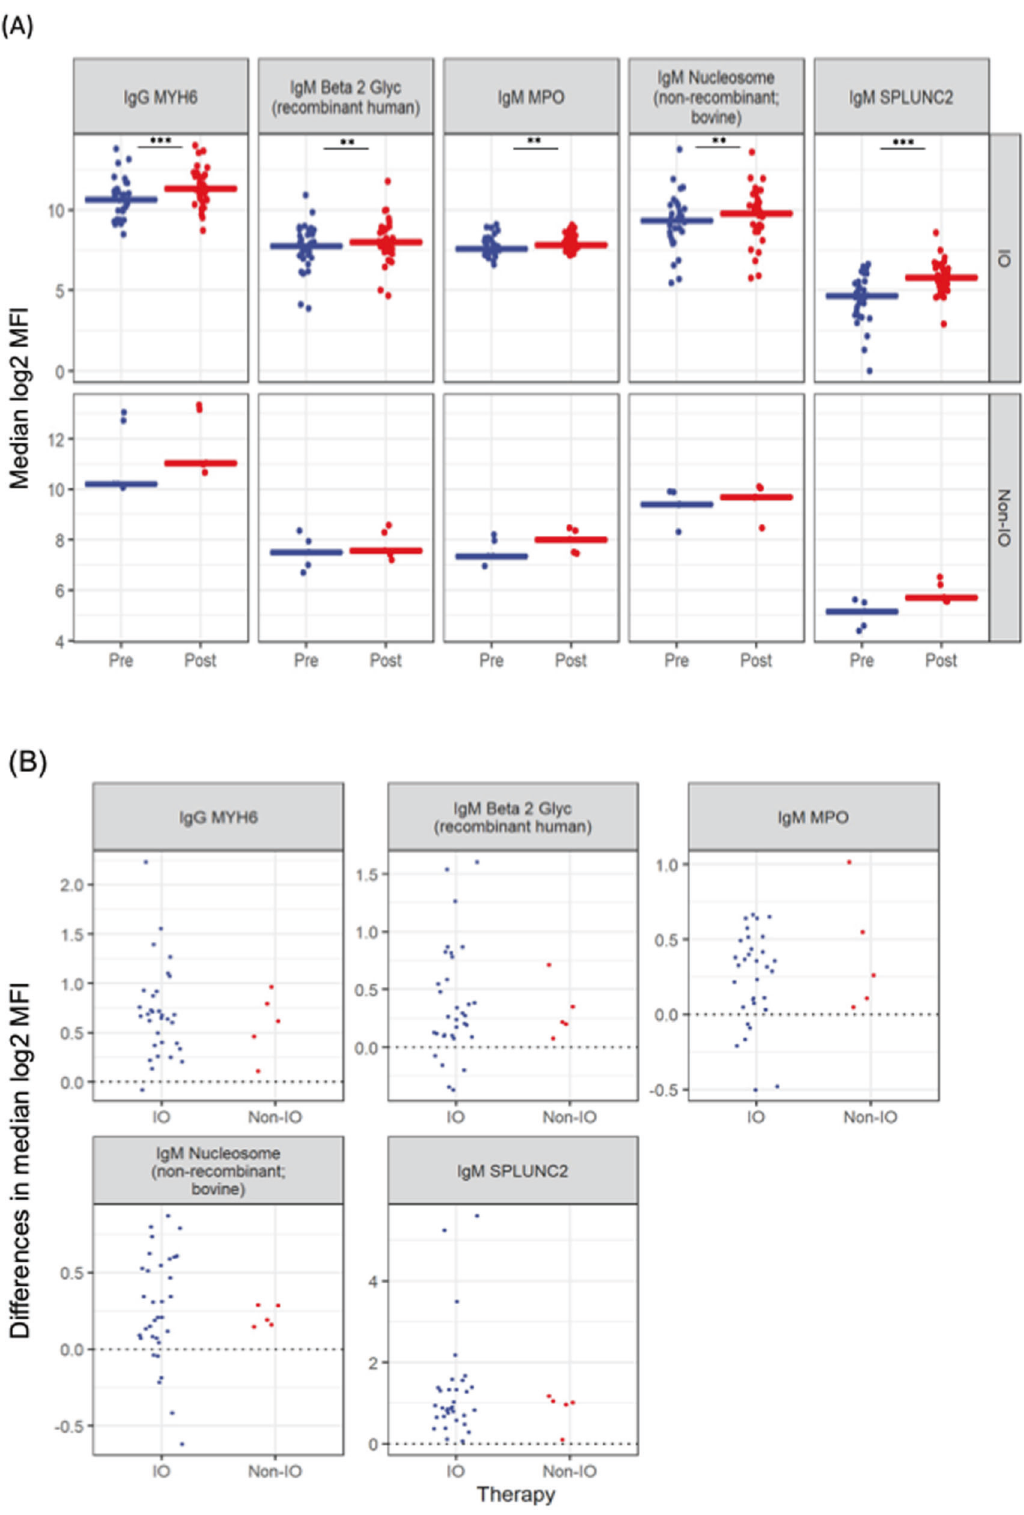
Fig. 4 Auto-antibody dynamic changes before and after vaccination. A Comparisons between autoantibodies found to be statistically different between baseline (pre) and following second vaccination dose (post) as measured by median log2 fl uorescence intensity (MFI) with a 161 self-antigen array. Top row shows patients treated with immunotherapy (IO, n = 33) and bottom row shows patients treated with non- immunotherapy (non-IO, n = 5). The logarithmic values of MFI are plotted here. Reported p -values indicate the effect of Time from the mixed effects ANOVA and refer to all patients (IO and non-IO) (*** p < 0.001; ** p < 0.01). There were no signi fi cant treatment effects. B Comparison of differences in MFI of the fi ve autoantibodies of interest between IO ( n = 33) and non-IO ( n = 5) groups. All comparisons were statistically non- signi fi cant with mixed effects ANOVA.